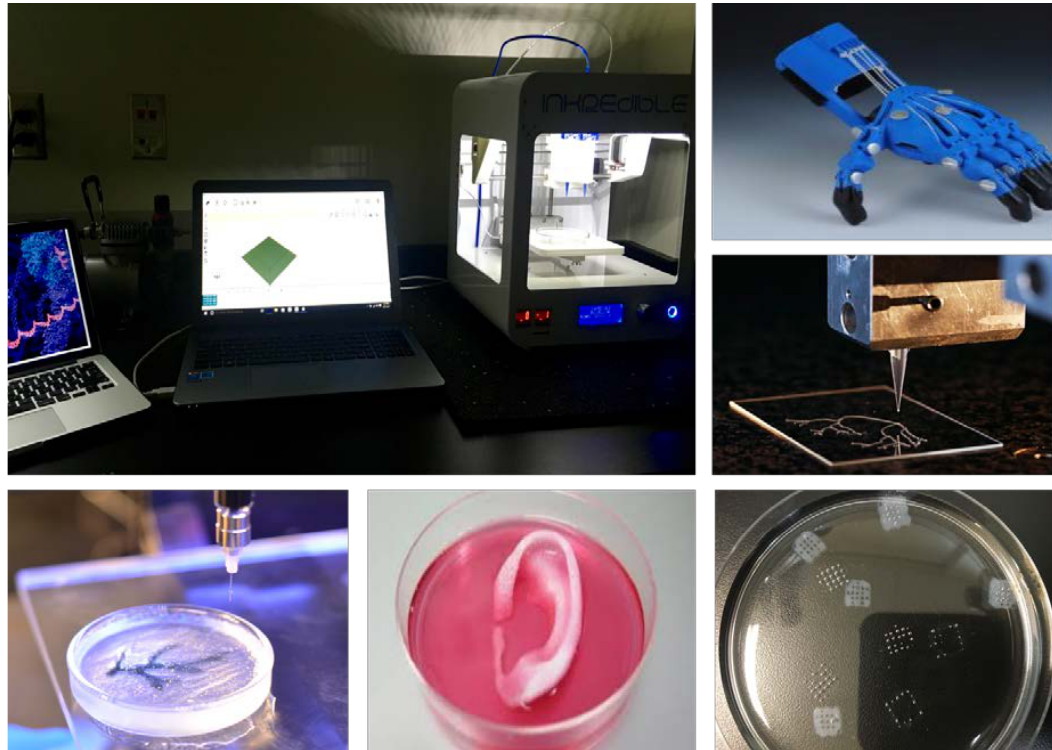
Figure 4. Bioprinting uses computer-aided design, bioinks, and a bioprinter to produce tissues and organs ( top left ). Three-dimensional printed prosthetics using thermoplastics will remain an essential clinical tool ( top right ). Examples of bioprinted tissues and organs include ducts ( top middle ), blood vessels ( lower left ), an external ear ( lower middle ), and bone implants ( lower right ).